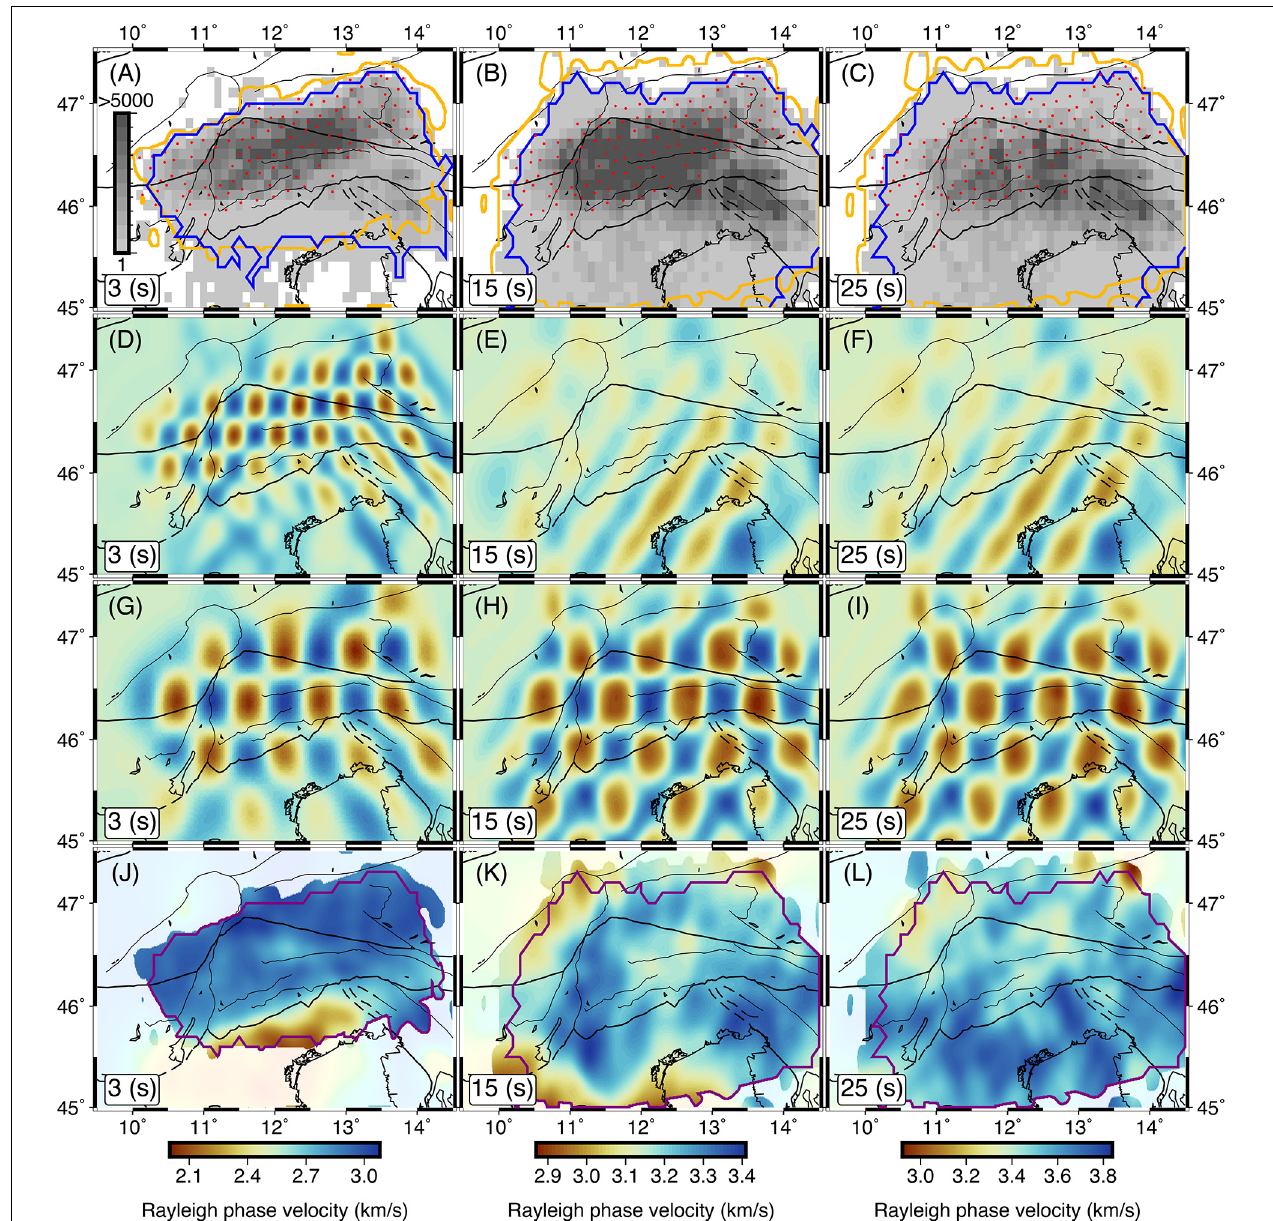
FIGURE 5 | Number of ray crossings in each 0.1 ◦ × 0.1 ◦ grid cell and stations of the ZS network (A–C) . The area with resolvability factor of higher than 0.7 and the tomographic grids with minimum of 20 ray crossings are shown by orange and blue polygons, respectively. Checkerboard reconstruction results with anomaly size of 0.3 ◦ × 0.3 ◦ (D–F) and 0.5 ◦ × 0.5 ◦ (G–I) , and tomographic inversion results at periods of 3, 15, and 25 s (J–L) . The purple polygon illustrates the overlapped area between the resolvability factor higher than 0.7 and the minimum of 20 ray